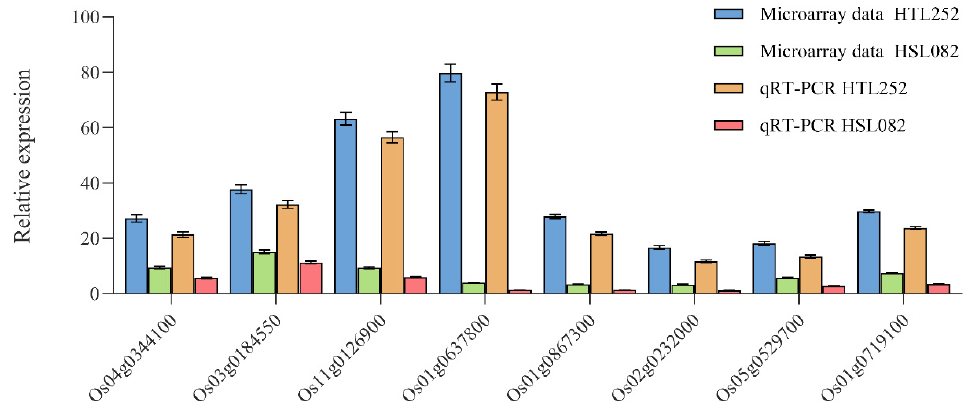
Figure 4. Verification through qRT-PCR. Eight genes were selected for qRT-PCR and compared with the microarray data. For each qRT-PCR, the transcription level of the rice 18S gene in different samples was also assessed. Quantification of gene expression was performed by using the relative quantification method (2 − ∆∆ CT ). “Microarray data HTL252” and “Microarray data HSL082” denote the results of HTL252 and HSL082 in the microarray, respectively; “qRT-PCR HTL252” and “qRT-PCR HSL082” represent the qRT-PCR results of HTL252 and HSL082, respectively. Values are mean average ± SE of three replicates.